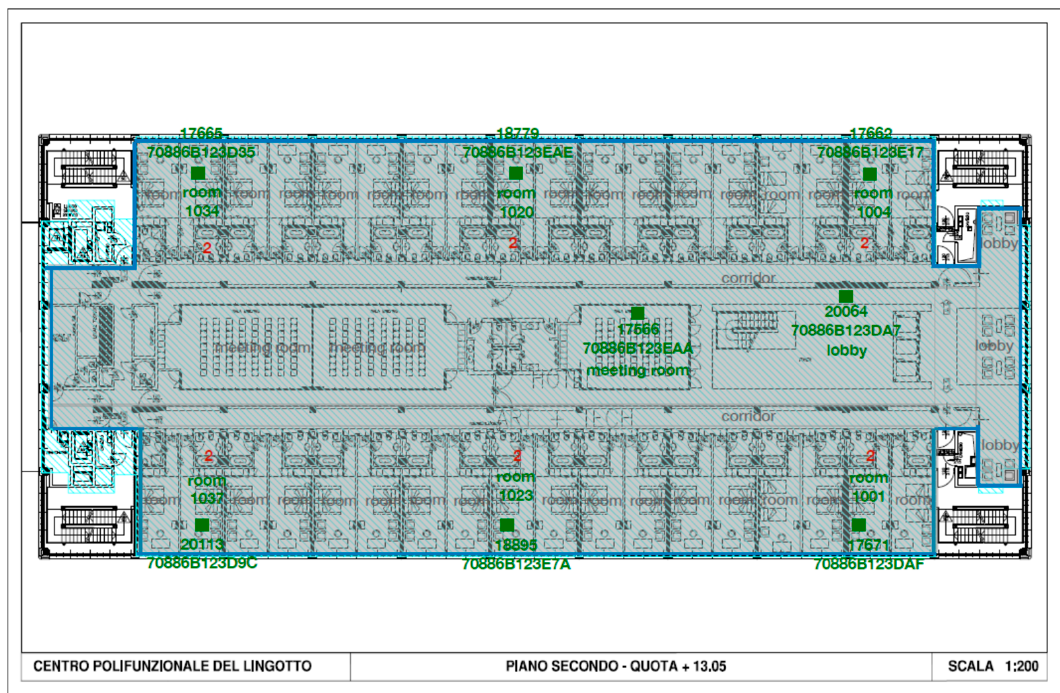
Figure 2. Floorplan of the rooms area, second floor, with indication about the placing of the moni- toring platform.